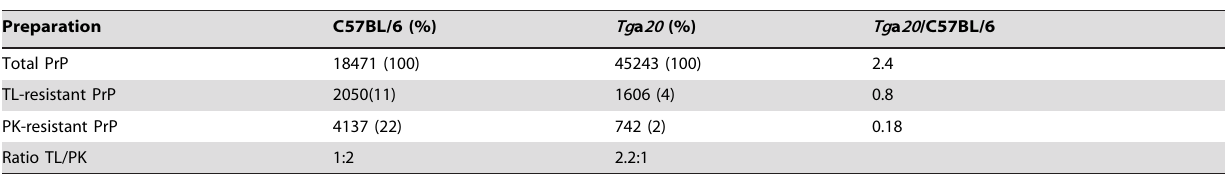
PrP in 22L-infected mouse brains (arbitrary units/ m g protein) Preparation